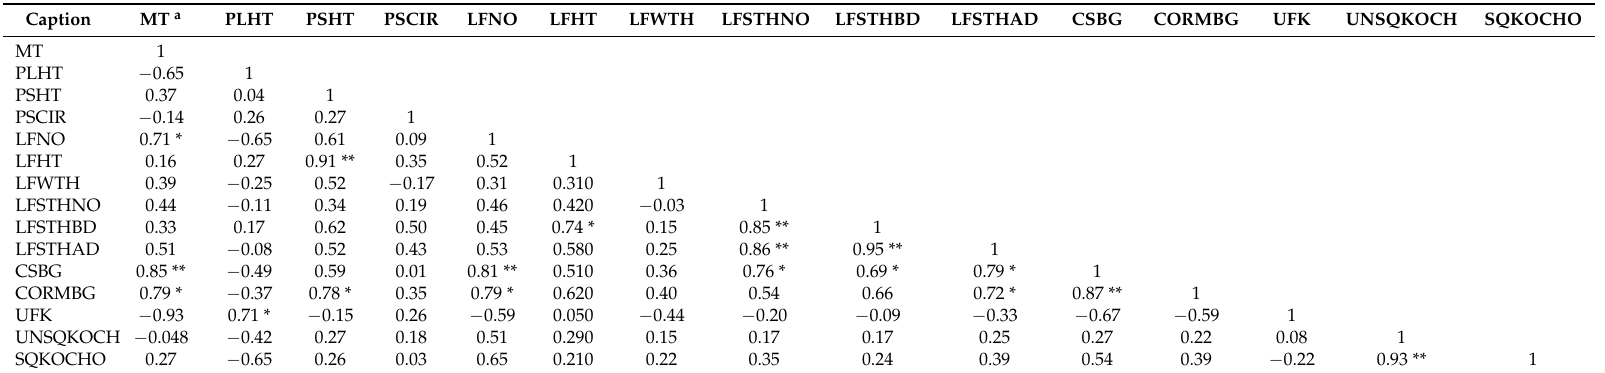
Table 7. Inter-region simple correlation coefficients among 15 quantitative characteristics (based on the mean of the 9 regions of